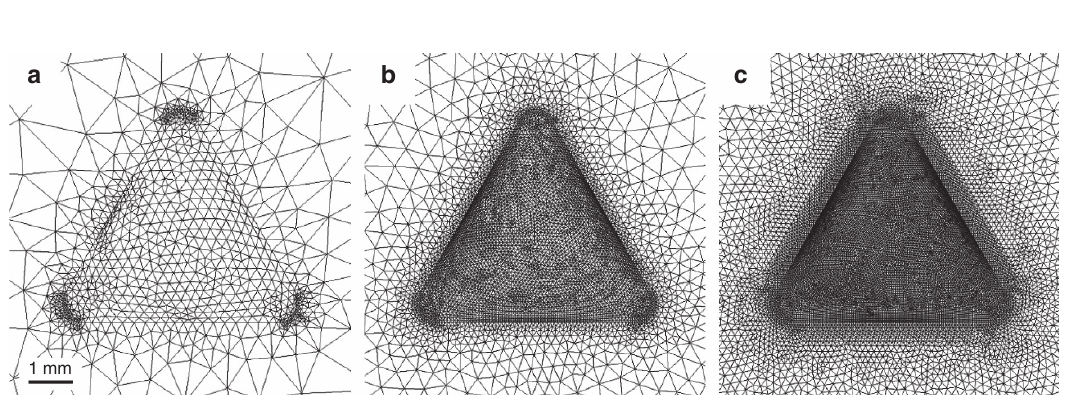
Figure 7 | Examples of grids around the drop with increasing element density considered in the mesh dependency test. Bottom view. According to Table 1: ( a ) coarsest, ( b ) fine and ( c )